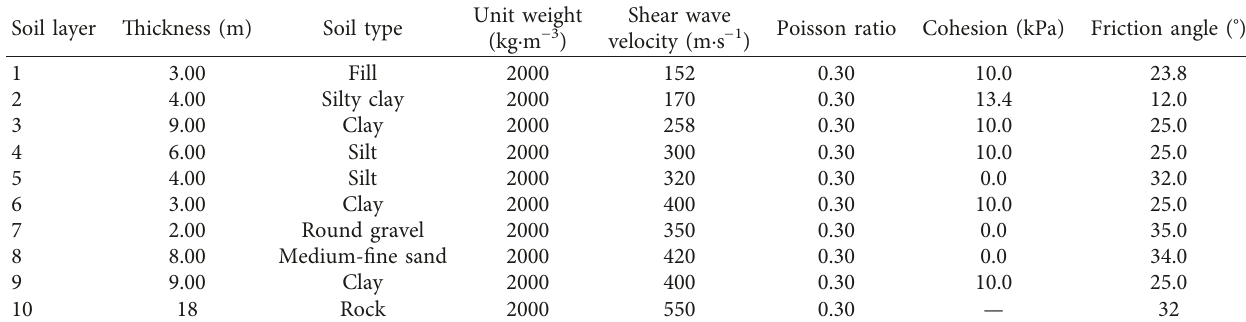
Table 3: Soil physical properties for site